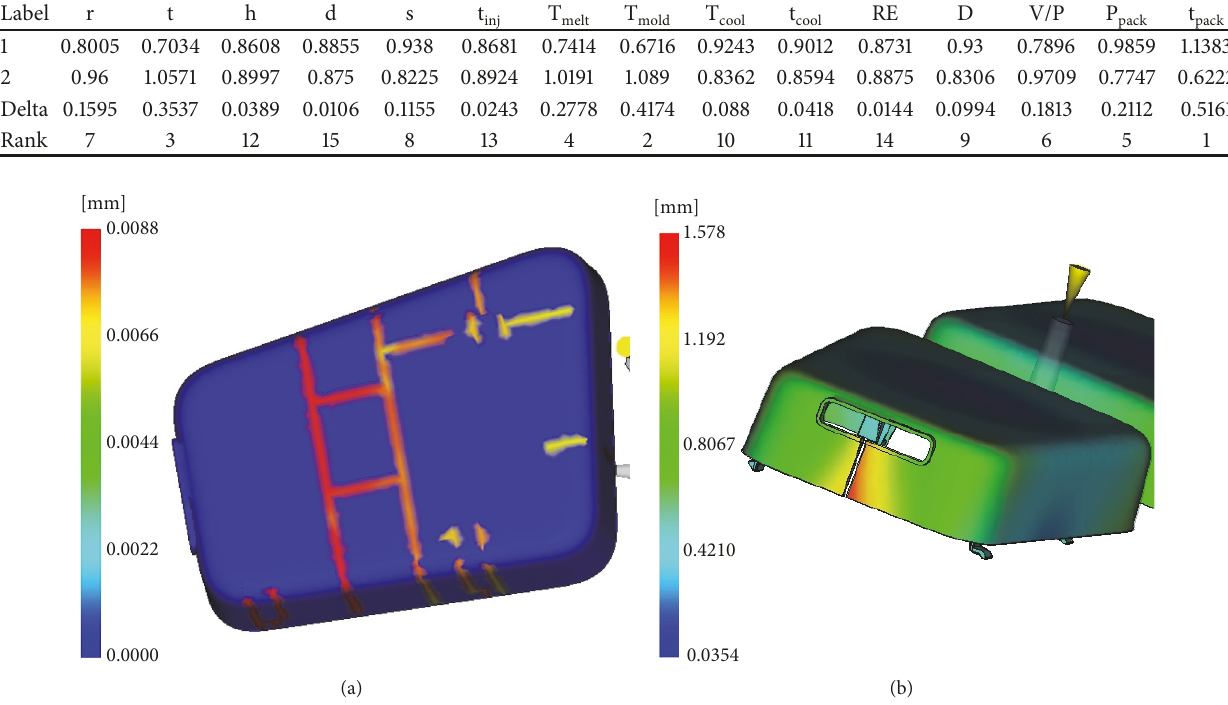
Figure 12: Simulation results under the optimized parameters: (a) sink marks and (b) warpage.